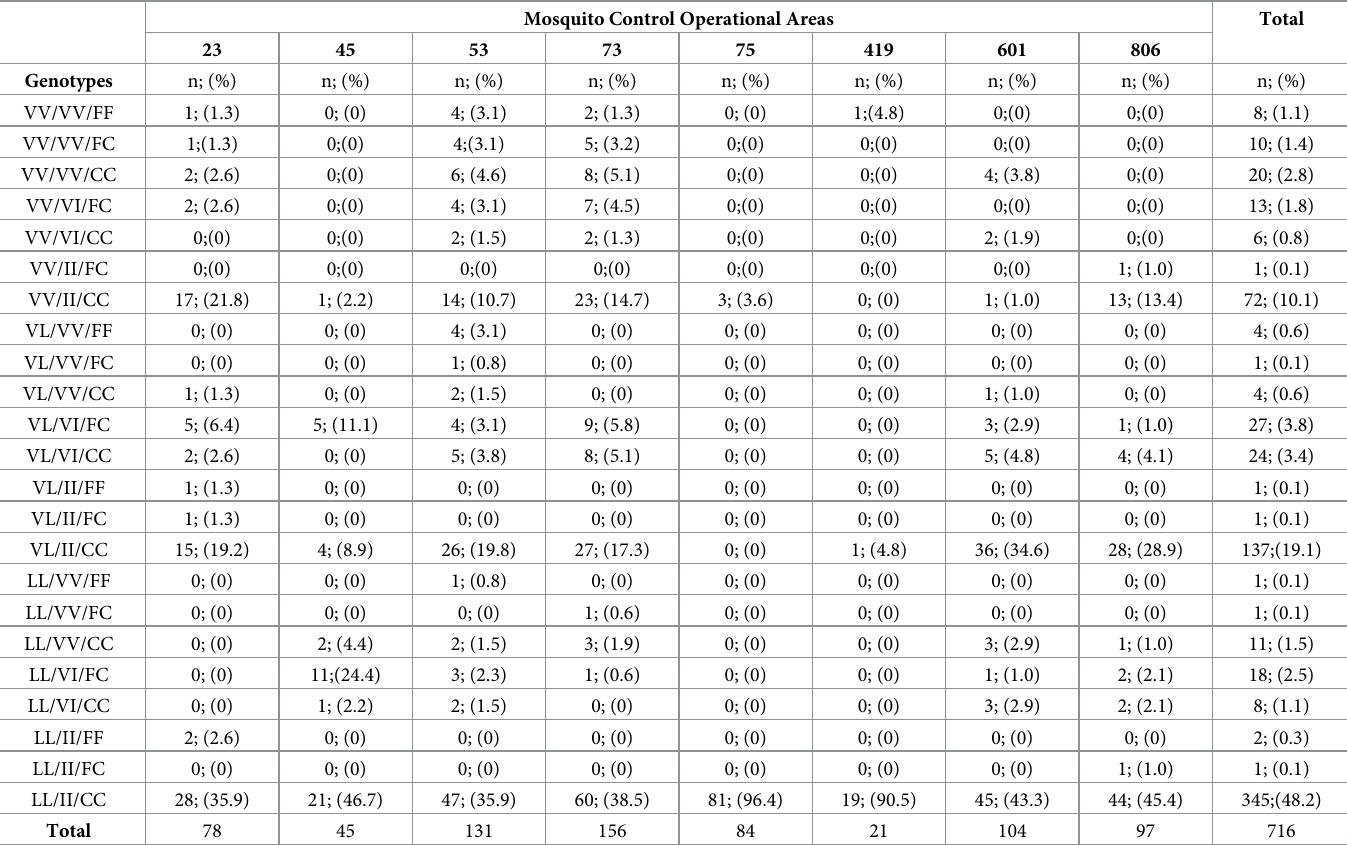
Table 2. Tri-locus VGSC genotypes at sites 410, 1016, and 1534 detected in Ae . aegypti females of Harris County by operational area. Mosquito Control Operational